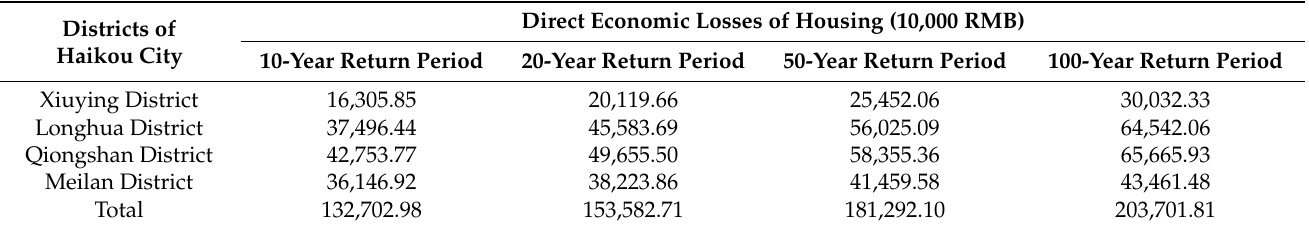
Table 5. Direct house losses in different flood return periods in the subdistrict of Haikou